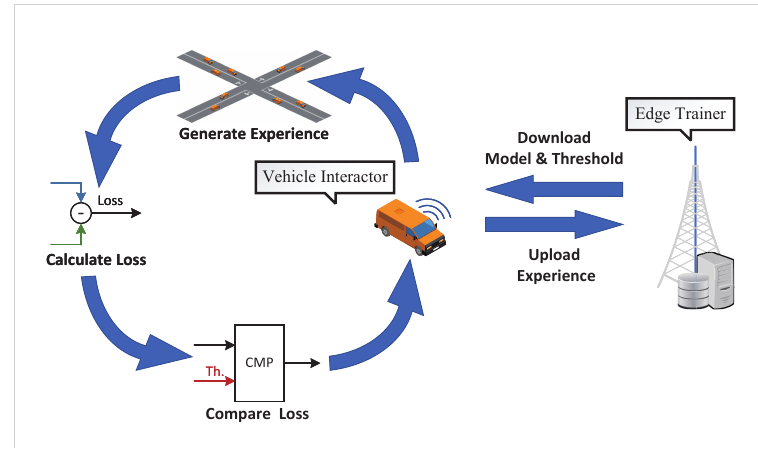
Figure 4. Loss-aware experience selection strategy.